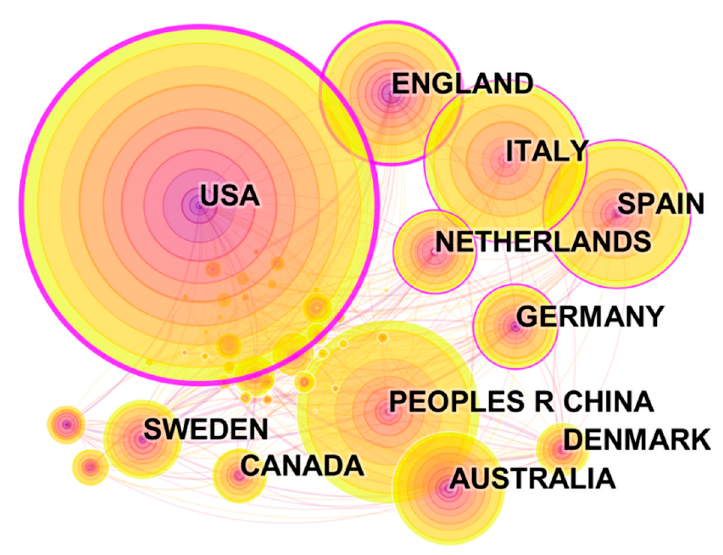
Figure A2. Journal co-citation network.